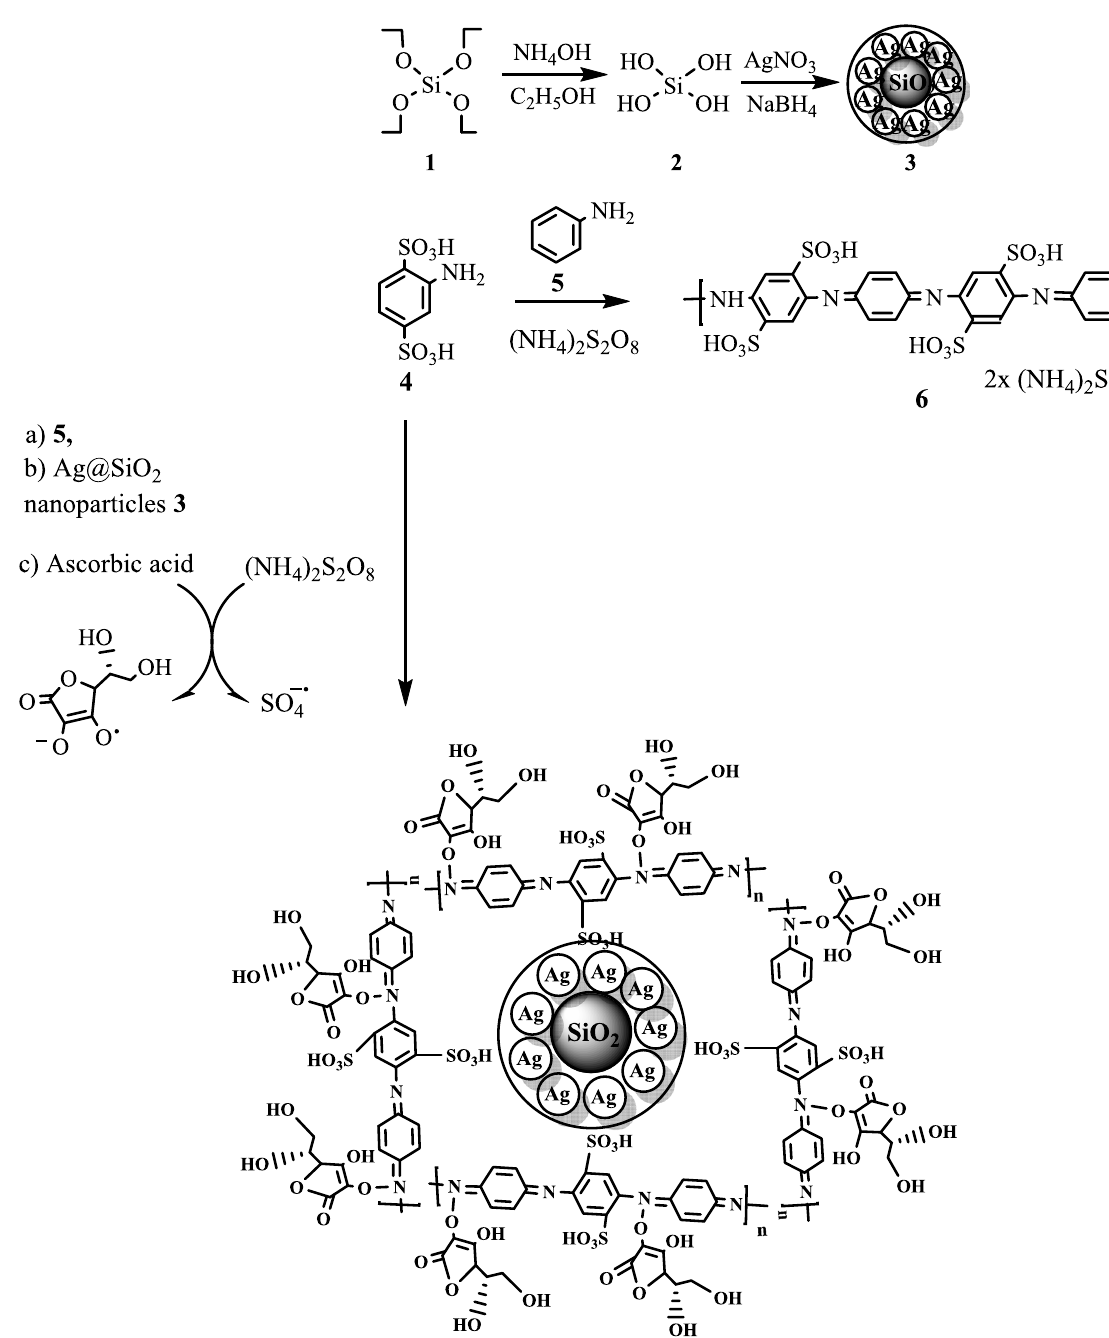
Fig. 2 Chemical synthesis of poly (aniline-co-aniline-2,5-disulfonic acid)/L-hexuronic acid/Ag@SiO 2 nanocomposite